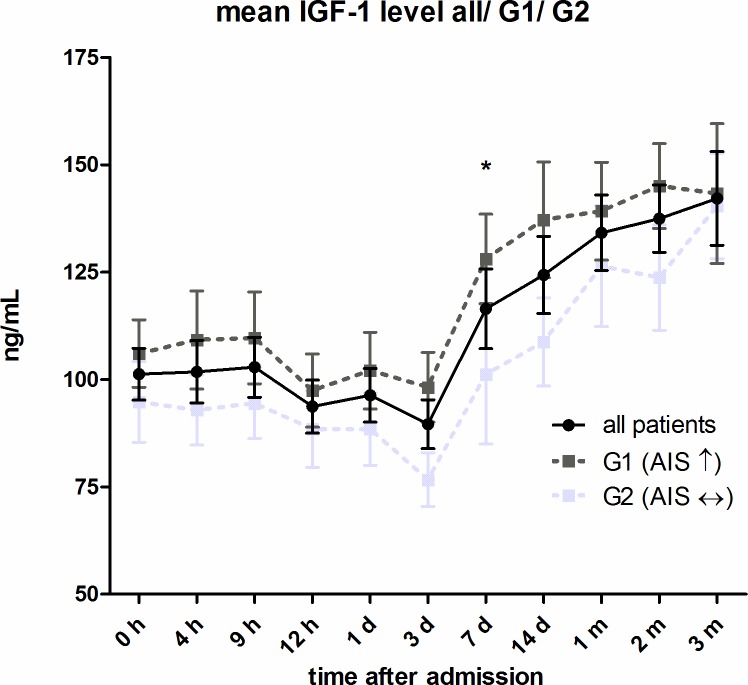
Mean IGF-1 serum level comparison of all patients with (G1) and without (G2) neurological remission.Expressed as mean values ± standard error of the mean. The Mann-Whitney-U-Test assessed significant differences between both groups at each particular time-point, *p < 0.05. For better illustration mean values of all traumatic SCI patients had been added to the figure.